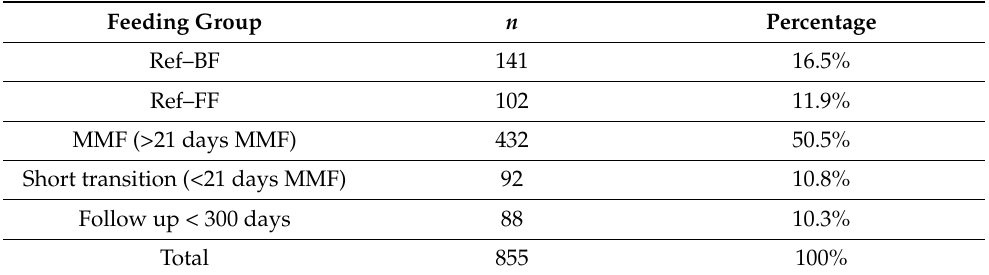
Table 1. Group sizes in TEMPO, including the percentage out of all of the subjects enrolled. Feeding